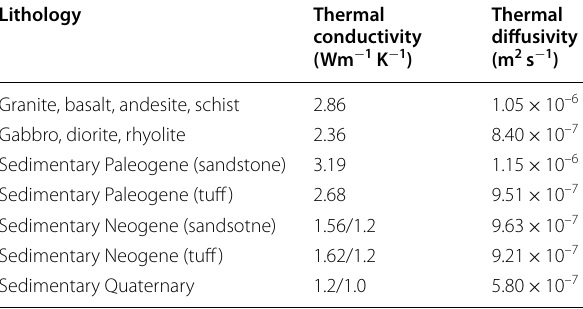
Table 1 Thermal conductivity and thermal diffusivity by lithology